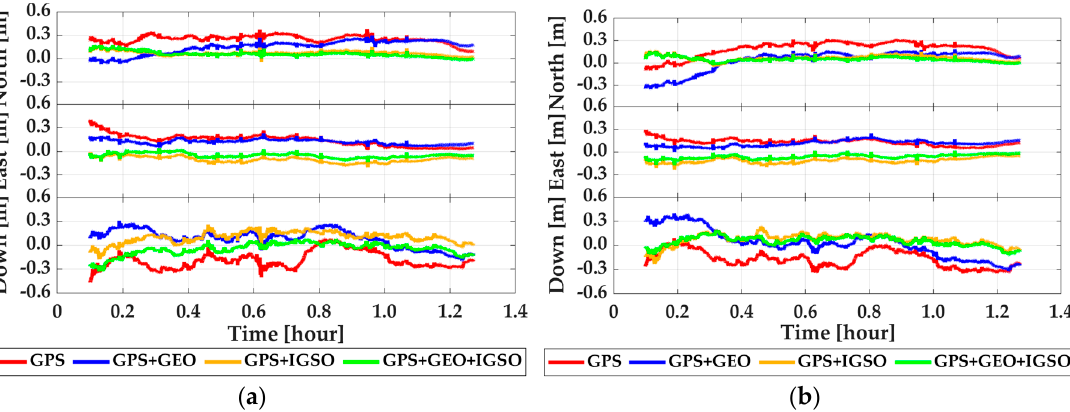
Figure 6 . Position offsets of PPP ( a ) and PPP/INS tight integration ( b ) by comparing with GPS + BDS RTK/INS tight integration solutions.